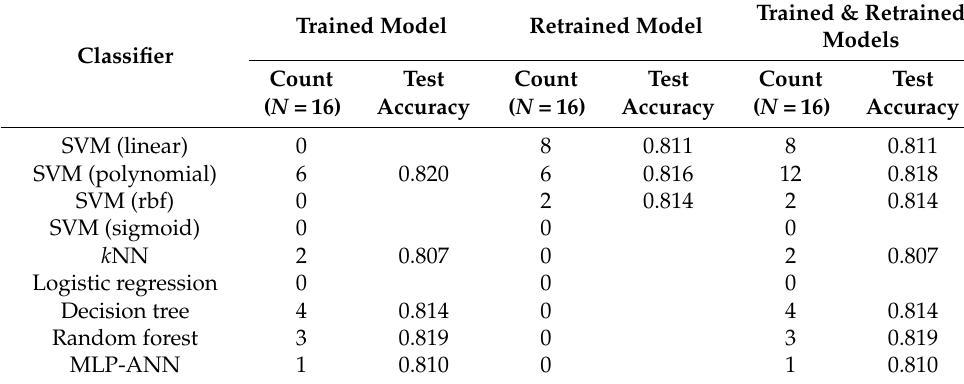
Table 5. The most accurate classifiers in 32 comparison